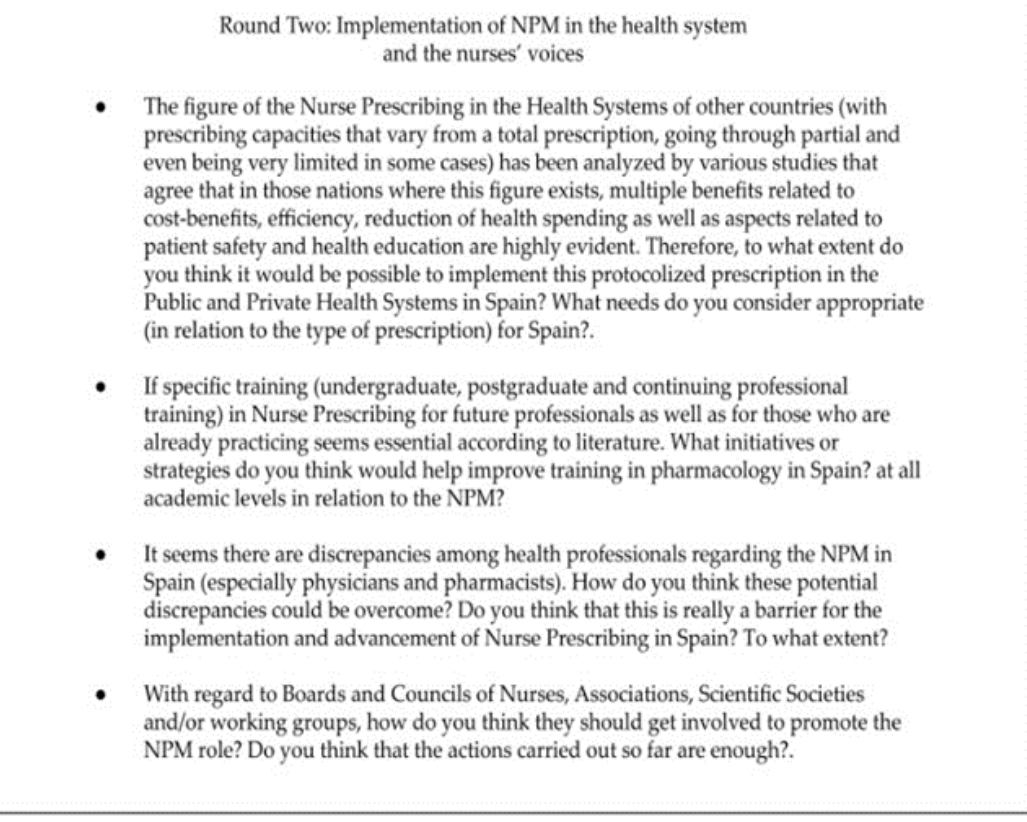
Figure 2. Round Two: Implementation of NPM in the health system and the nurses’ voices.